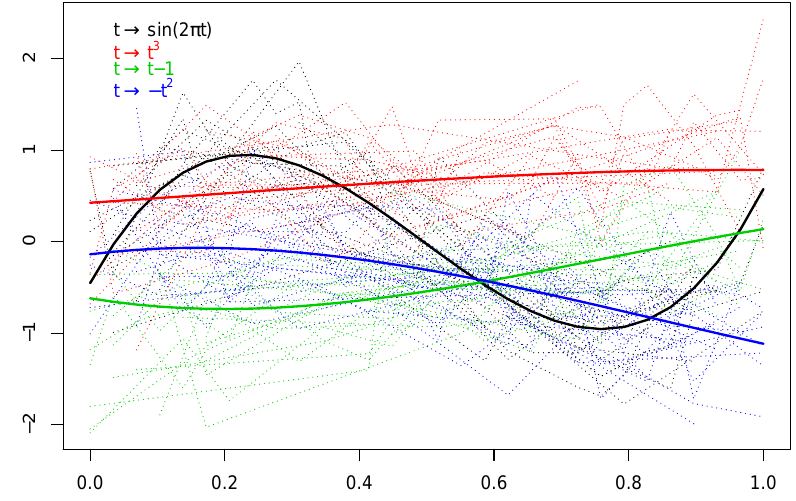
Figure 4. All curves (dotted lines) and cluster centres’ curves (plain lines) obtained with iterSubspace algorithm for the simulated Sample 3. Both clustering and detecting underlying shapes become difficult. The high noise makes the clustering fuzzy, which is affecting the cluster central